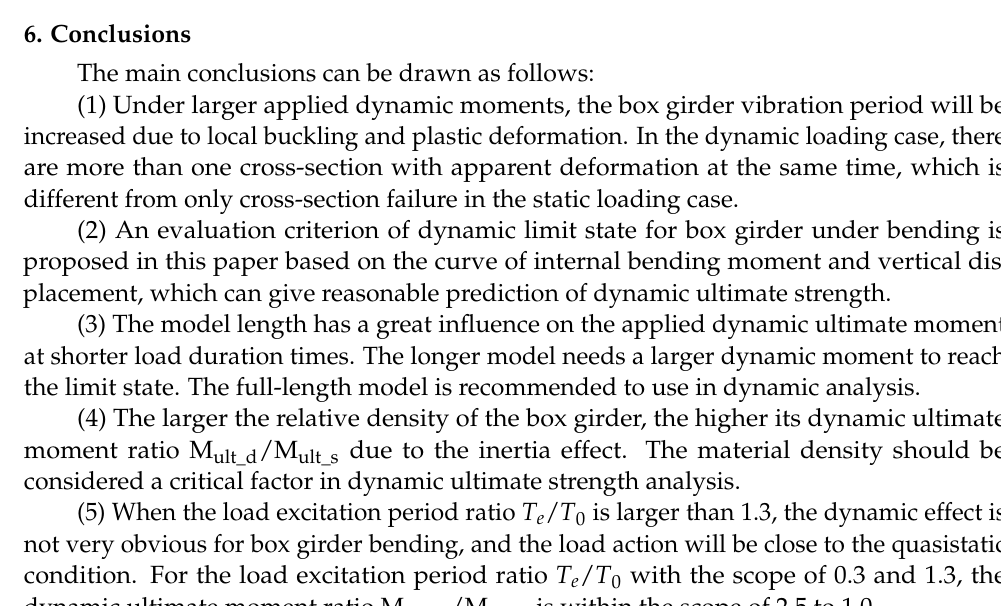
Figure 20. Effect of load excitation period on dynamic ultimate moment of box girder M2.